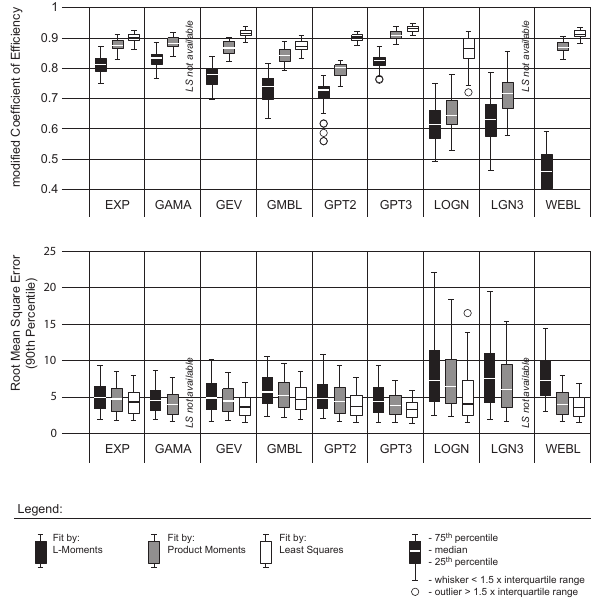
Fig. 6. Box plots showing the spread of mCOE (upper chart) and RMSE90 (lower chart) values across the 42 pluviograph stations. The results indicate the spread of values associated with each of the nine TDFs and the three fitting methods (note that the least squares estimation technique was not able to be employed for the GAMA and LGN3 distributions). High fitting skill is indicated by mCOE values close to 1.0 and by RMSE90 values close to zero. Note that while outliers are identified above, this does not imply data was removed from any subsequent